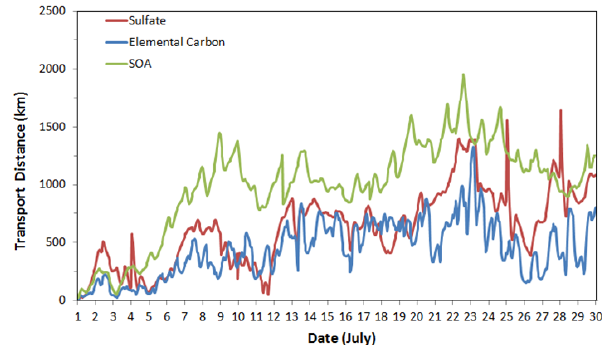
Fig. 6. Temporal variation of the transport distance for EC, sulfate and SOA at ground level for Paris emissions for the simulated sum- mer period.